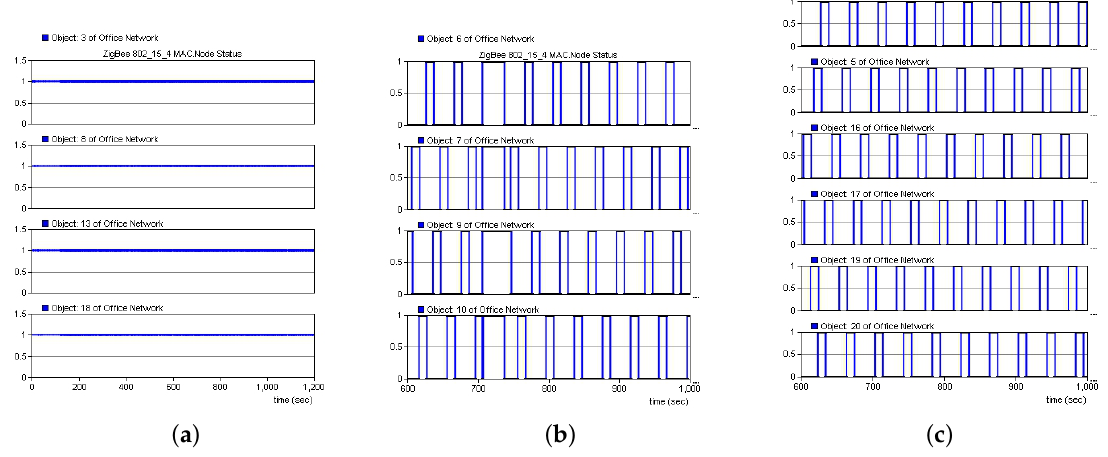
Figure 11. Node status. ( a ) Coordinator and routing nodes. ( b ) Networking nodes. ( c ) Nodes in the normal working state.